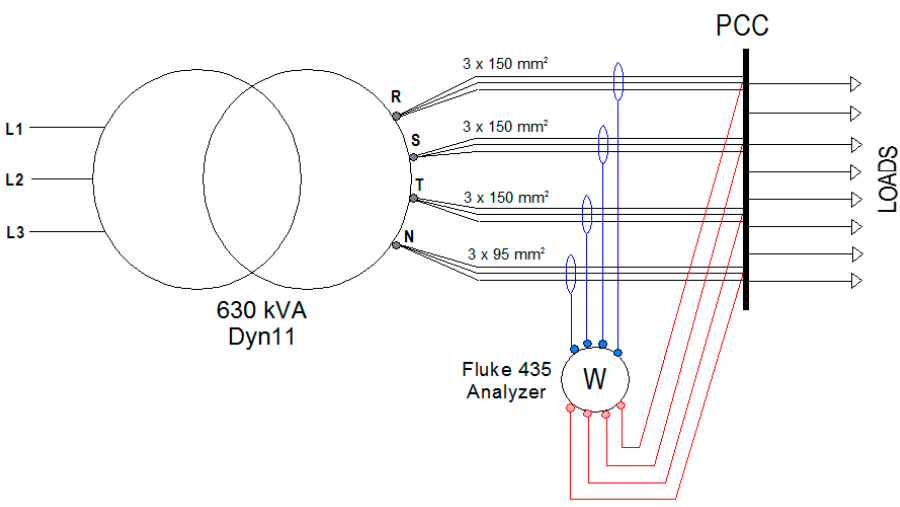
Figure 8. Scheme of the actual residential distribution network used in the application example and placement of the Fluke 435 Series II analyzer.